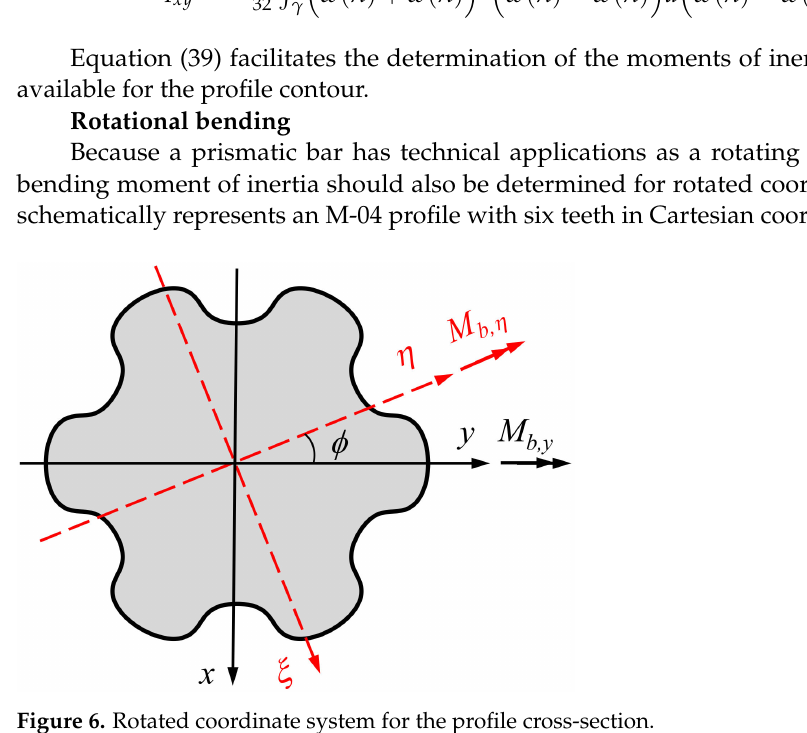
Figure 6. Rotated coordinate system for the profile